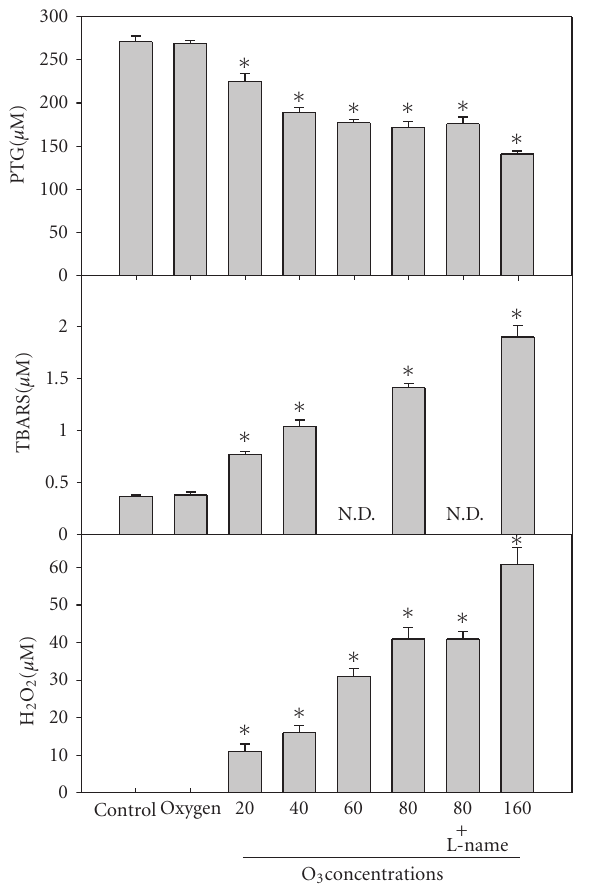
Figure 1: E ff ect of either oxygenation (O 2 ) or ozonation at ozone concentrations of 20, 40, 60, 80, and 160 μ g/mL gas per mL of blood (three blood samples of the same donor collected in heparin). To one sample L-NAME, (20 mM) was added. The diagram reports the determinations of protein thiol group (PTG), thiobarbituric acid reactive substances (TBARS), and H 2 O 2 . The statistical significance has been indicated with ( ∗ )